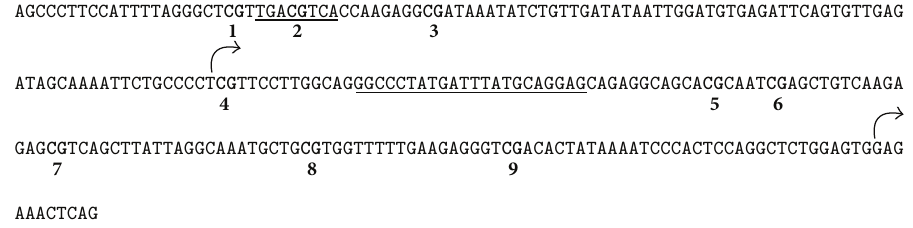
Figure 3: DNA sequence of the CRH proximal promoter. The methylatable CpG dinucleotides are in boldface and are numbered 1 to 9. The canonical CRE, which contains CpG2, and the noncanonical cAMP-response regions are underlined. The two major transcription initiation sites are flagged by the arrows.